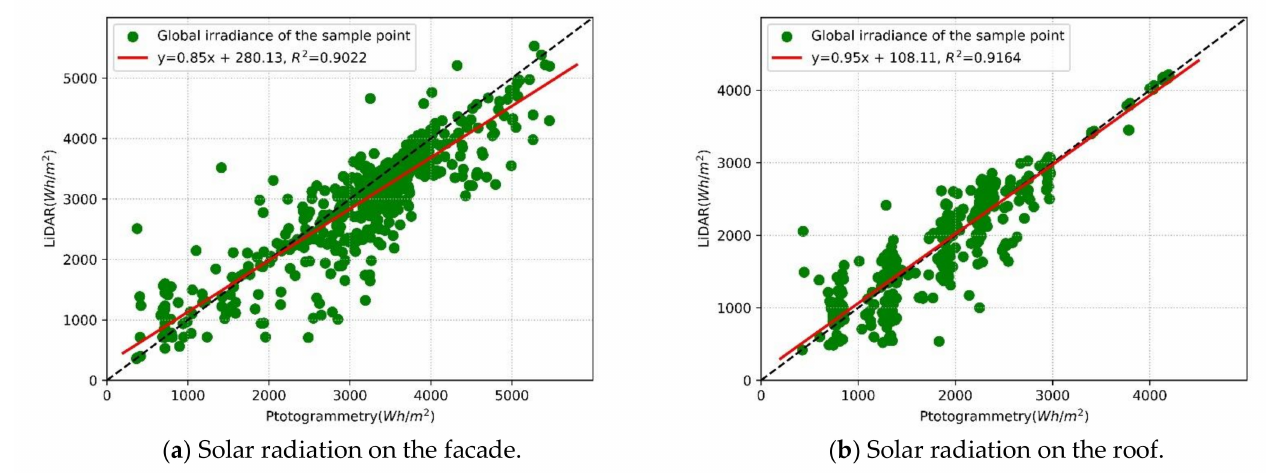
Figure 15. Correlation